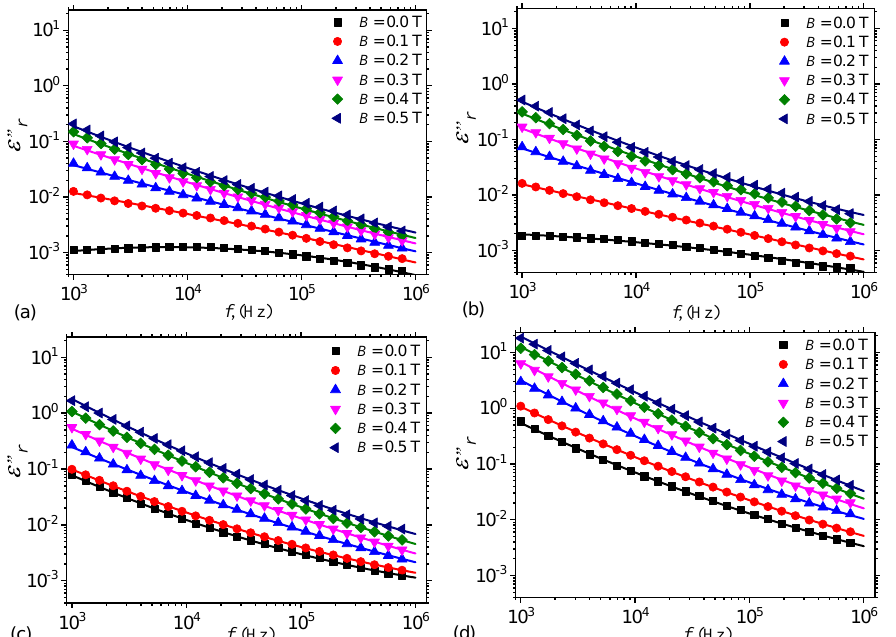
Figure 8. Variation of dielectric loss factor (cid:101) (cid:48)(cid:48) r with frequency f , at fixed values of magnetic flux density B . ( a ) hMAC. ( b ) hEMAC 1 . ( c ) hEMAC 2 . ( d ) hEMAC 3